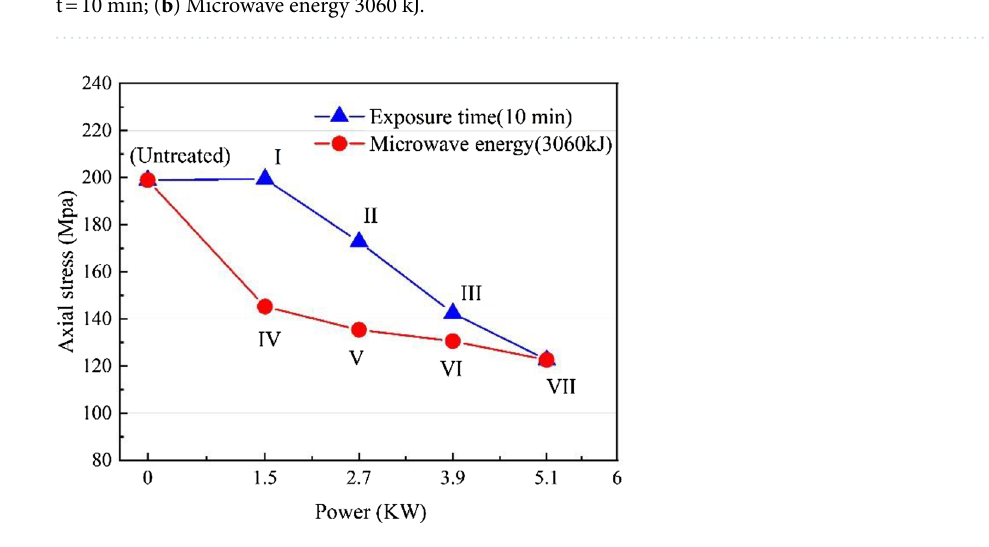
Figure 9. Relationship between UCS of samples with microwave power